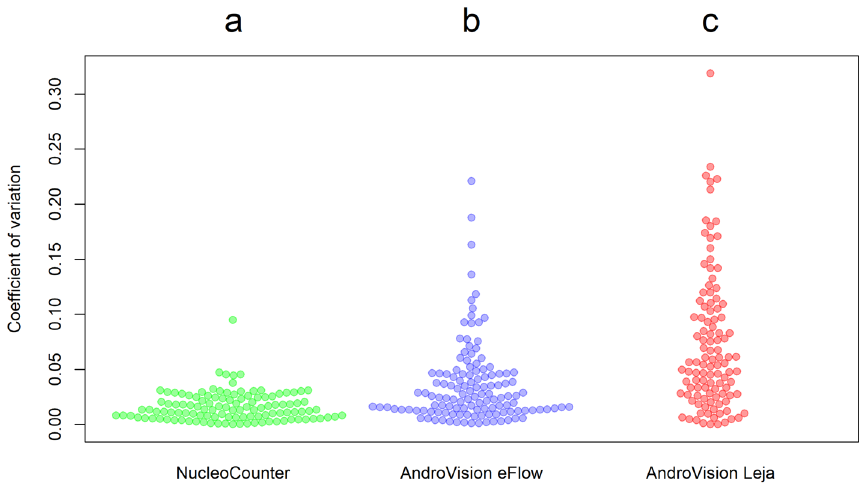
Figure 4. Plots of coefficient of variation (CV) of sperm concentration double measurements with NUCLEOCOUNTER, ANDROVISION eFlow and Leja chamber, respectively ( a,b,c P < 0.0001).